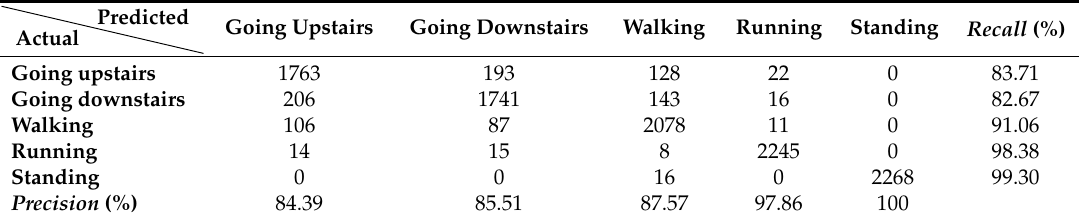
Table 5. Confusion matrix of activity recognition.